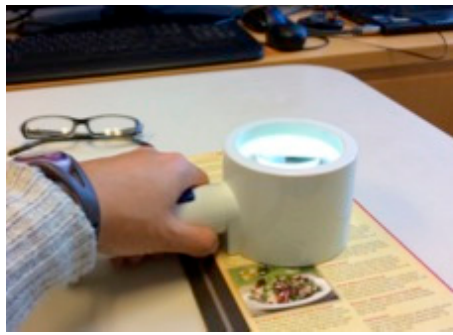
Figure 12. Stand magnifier with illumination.